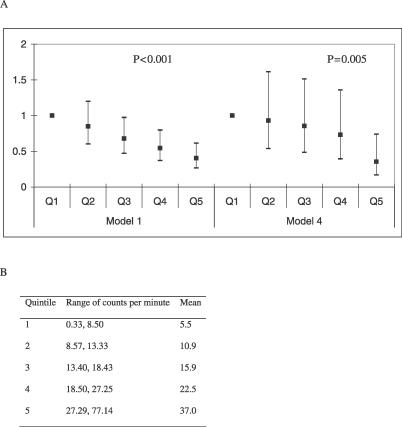
Adjusted Odds Ratios for Obesity by Quintiles of Objectively Measured Minutes of Moderate and Vigorous Activity in 2,878 12-Year-Old Girls from ALSPAC(A) Model 1 gives the odds ratios from the minimally adjusted model, i.e., obesity (adjusted for age, height, and height squared) regressed on quintiles of MVPA.Model 4 gives the odds ratios from the maximally adjusted model, i.e., obesity (adjusted for age, height, and height squared) regressed on quintiles of MVPA, maternal education, lowest social class, birthweight, gestational age, smoking in pregnancy, obesity of mother, sleep pattern, TV viewing, and pubertal stage.(B) Mean and ranges of quintiles of minutes of moderate and vigorous activity for girls